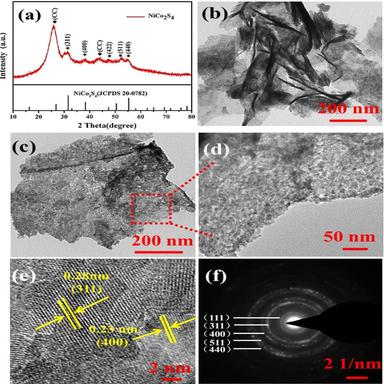
(a) XRD pattern of NiCo2S4/CC. (b) TEM image of NiCo2O4/CC. TEM images with low and high-magnifications (c, d and e) and SAED pattern (f) of NiCo2S4/CC.